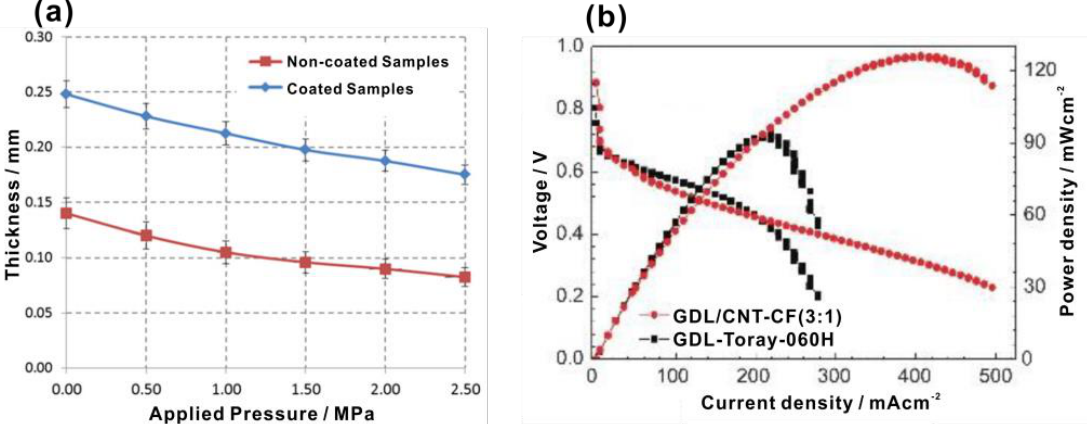
Figure 11. ( a ) Correlation between the thickness of the GDL and applied compressional pressure within 0.5 and 2.5 MPa. The data points on the top represent the GDL containing MPL and the data points at the bottom represent the GDL without MPL. Reproduced with permission [103]. Copyright